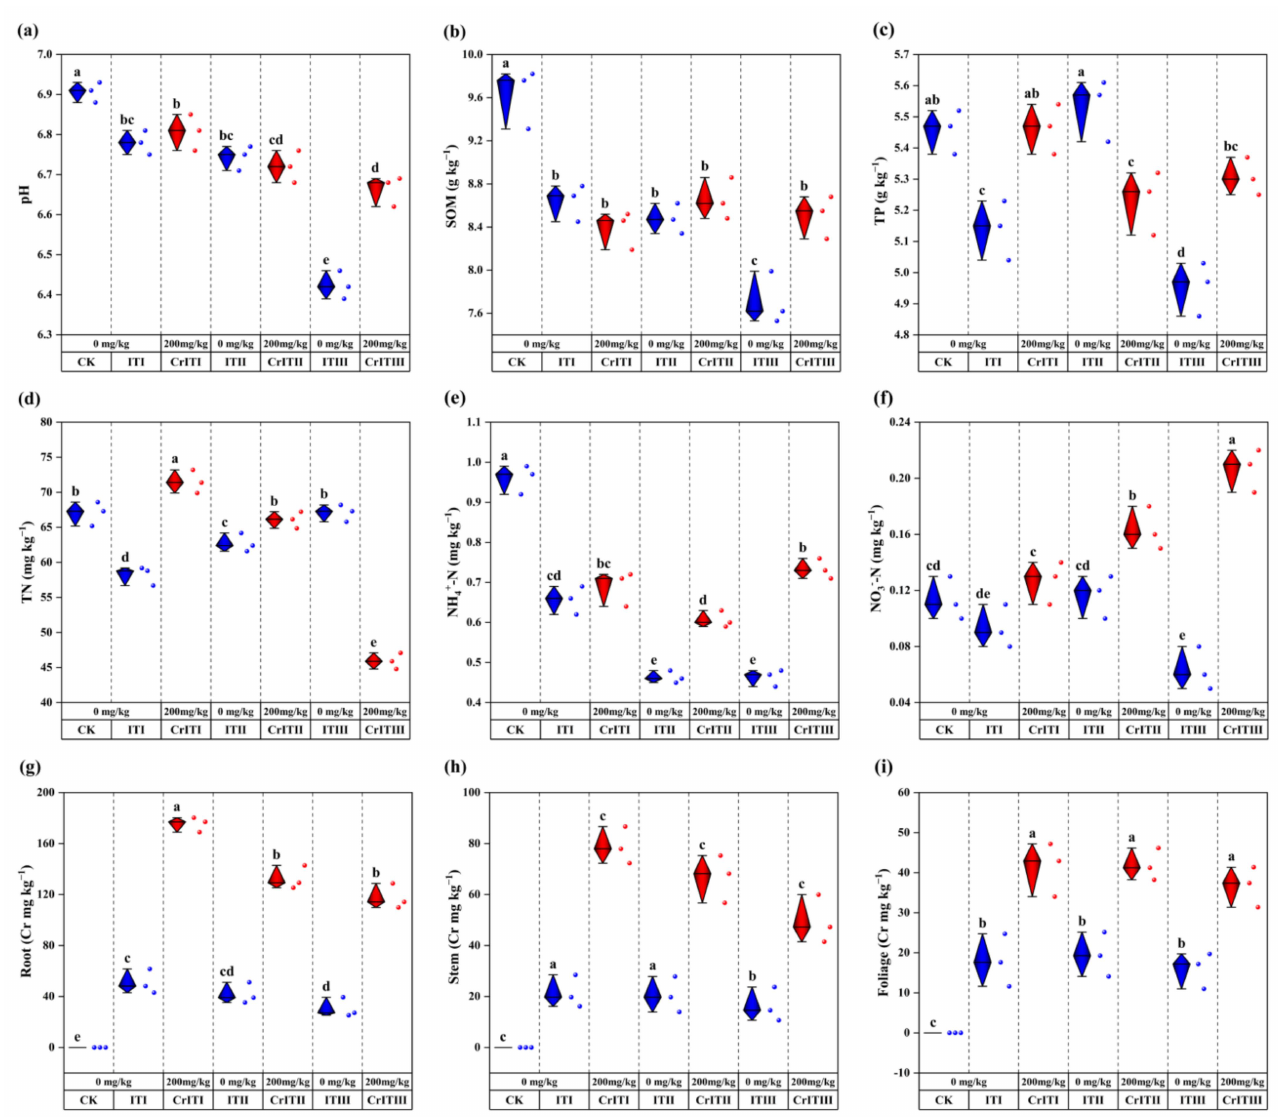
Figure 1. I. tectorum heavy metal content and soil physicochemical properties under Cr stress (( a – i ): pH, SOM, TP, TN, NH 4+ -N, NO 3 − -N, Cr content in roots, foliage, and stems). Data within the same followed by a string of the same lowercase letters are not significantly different ( p > 0.05). At the same time, a series of other letters show a significant difference ( p <